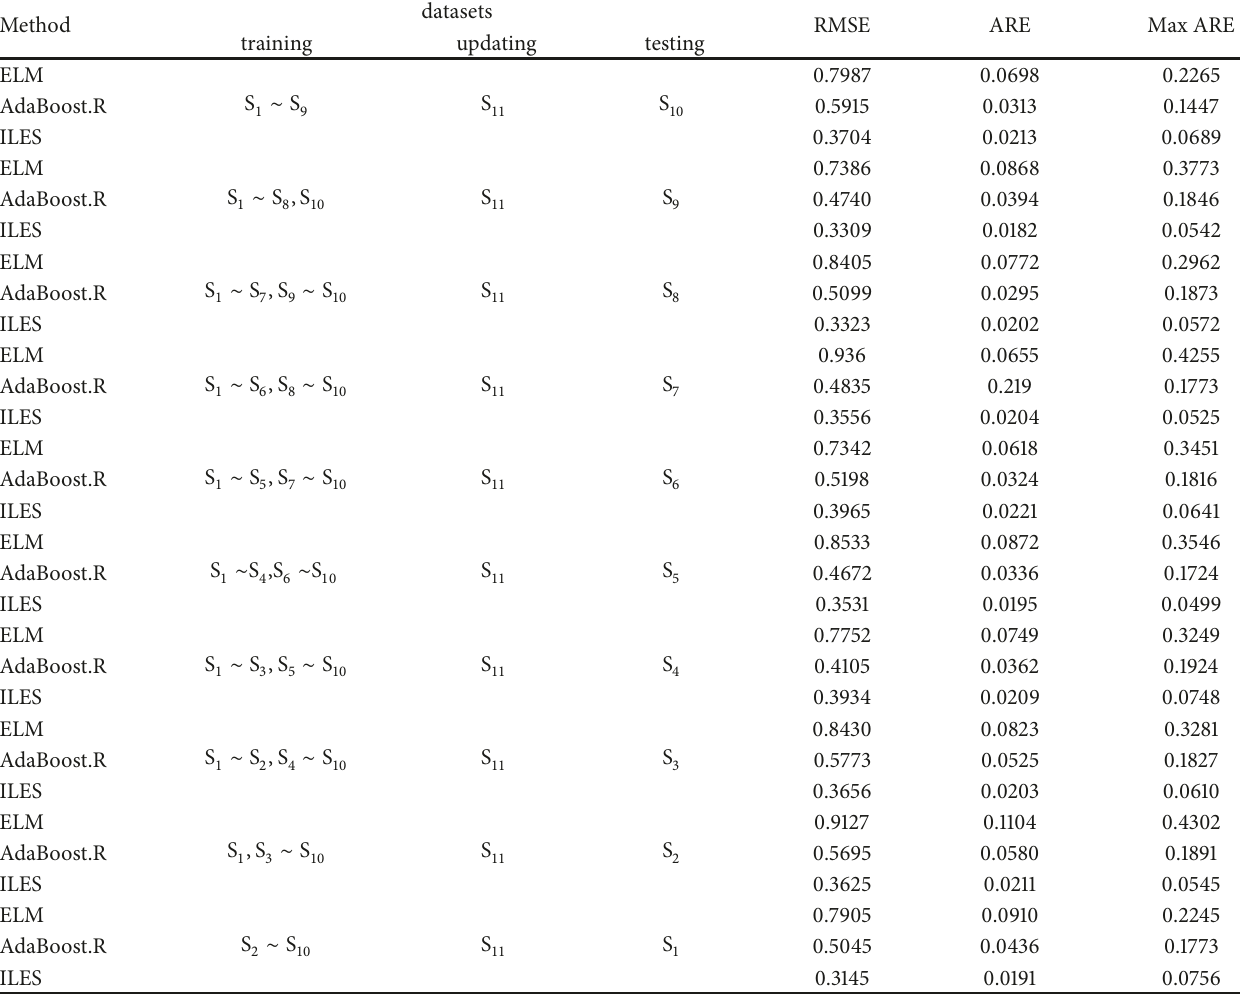
Table 3: The performance of the soft sensor model based on different methods with 10-fold cross validation.